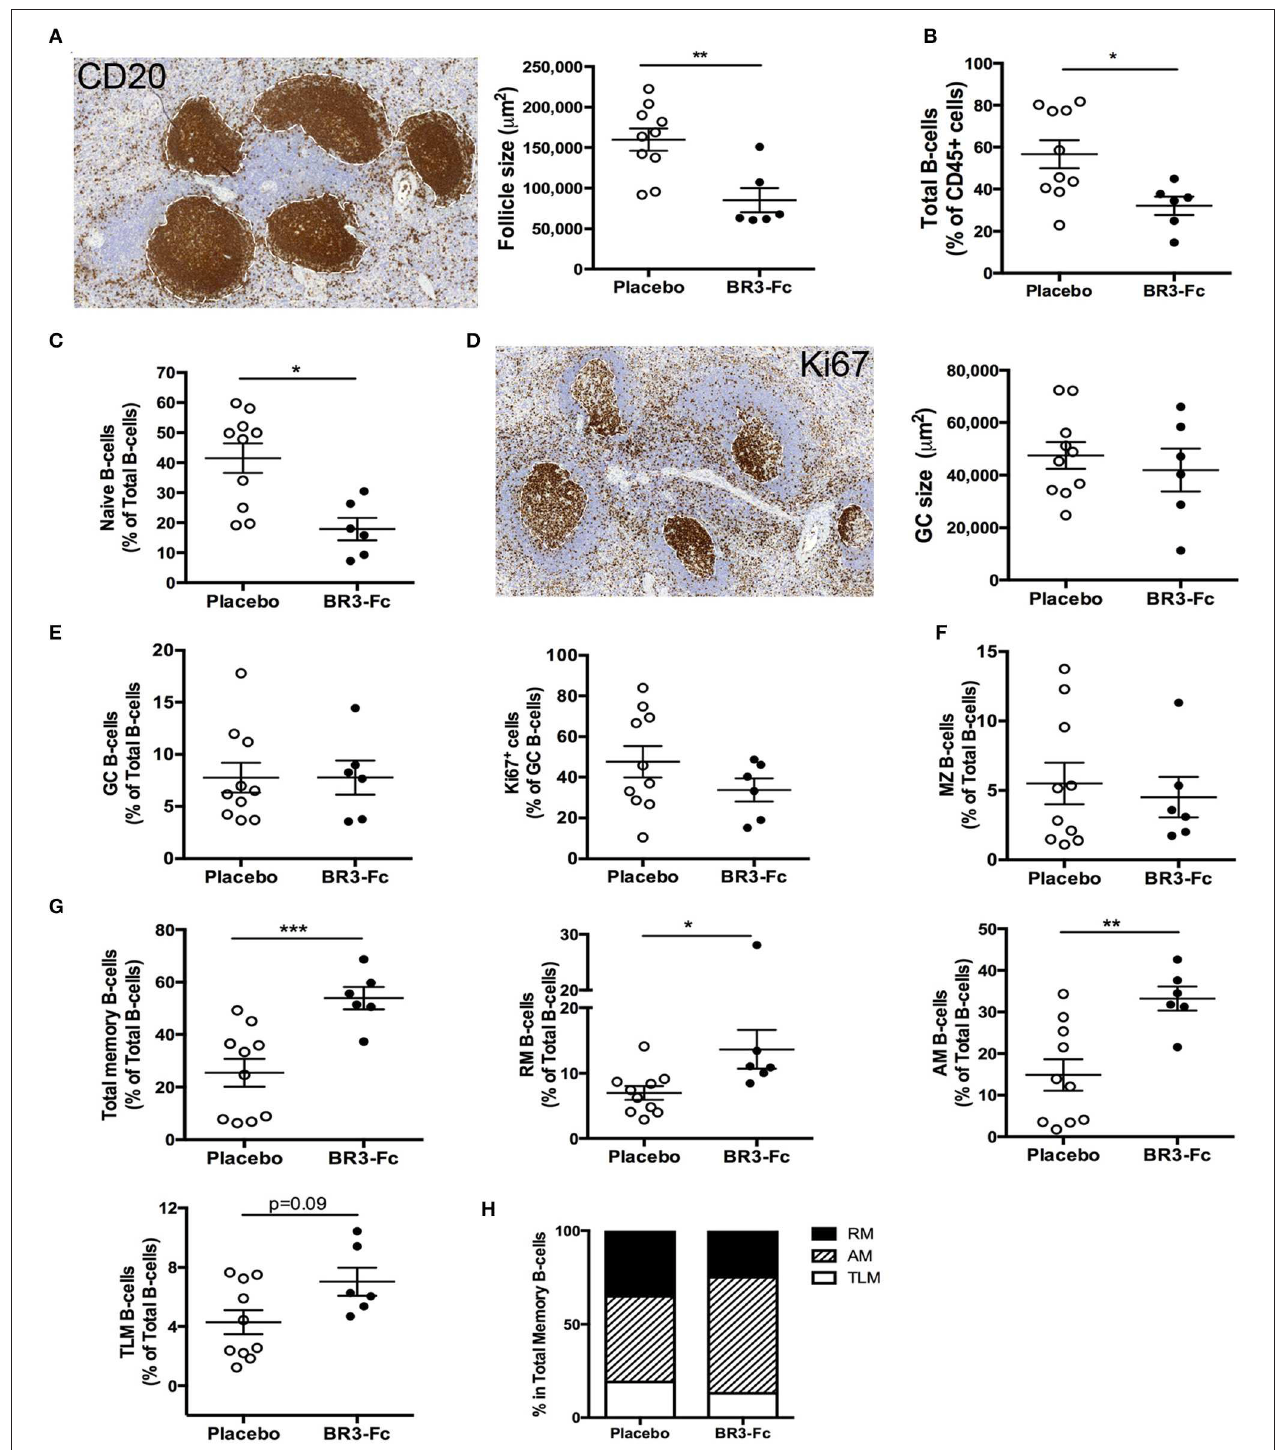
FIGURE 4 | Higher proportions of activated memory B-cells in spleen and changes in BAFF receptor expression after BR3-Fc treatment. (A) Representative CD20 staining (left) on sections of spleen from one Placebo macaque. For each section, the size of all follicles was determined using Pannoramic Viewer software. Average size of follicles for each macaque was shown (right panel). (B) Proportions of total spleen B-cells (CD19 + CD20 + ) in CD45 + cells were determined by multi-parameter FCM for each macaque. (C) Proportions of naïve B-cells among total B-cells were determined by multi-parameter FCM for each macaque according to the gating strategy shown in Figure S3 . (D) Representative Ki67 staining (left) on sections of spleen from one Placebo. The average size of GC was determined using